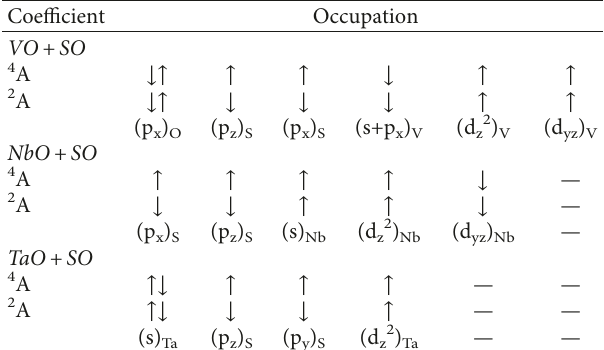
Table 2: Outermost valence configurations for the quadruplet and doublet electronic states of the radical fragments